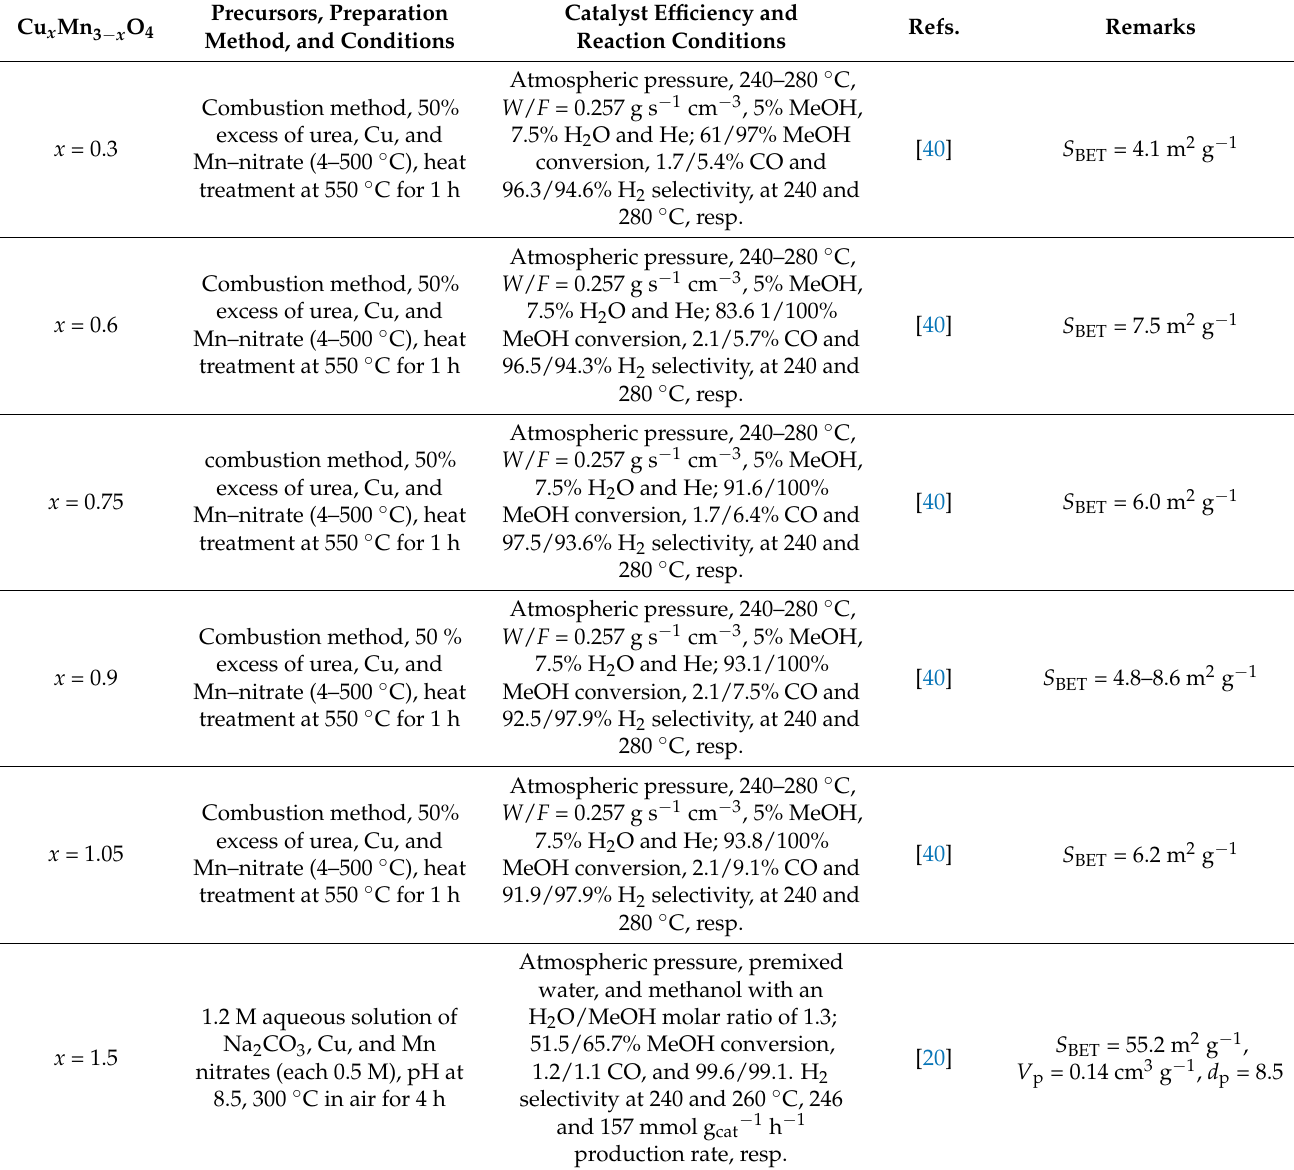
Table 12. Steam reforming of methanol in the presence of catalysts containing copper manganese oxide